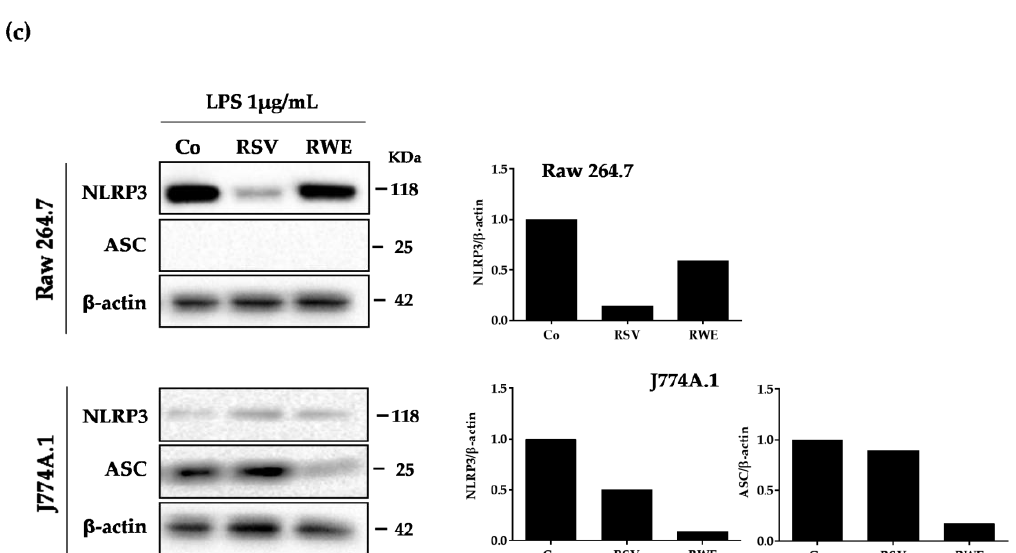
Figure 2. RWE and RSV decrease IL-1 β secretion in lipopolysaccharide (LPS)-mediated NLRP3 inflammasome priming conditions. Raw 264.7 ( a ) and J774A.1 ( b ) macrophages were pretreated or not with RWE (100 µ g/mL) or RSV (60 µ M) for 30 min, prior to NLRP3 inflammasome priming with 1 µ g/mL of LPS for 5.5 h. Secreted IL-1 β in cell supernatants was analyzed by ELISA at the end of the treatments. Data are expressed as fold changes in secreted IL-1 β levels as compared to cells treated with LPS alone (Co) and are mean ± s.d. of three independent experiments. p -values were determined by the multiple Student t test. ** p < 0.01 ( c ) Western-blot analysis of NLRP3 and ASC protein expression in Raw 264.7 and J774A.1 macrophages after cell treatments as described above. Left panels: representative blots from three independent experiments are shown. β -actin was used as loading control. Right panels: densitometry quantifications of representative blots. Plotted data are fold changes as compared to LPS-treated cells (Co).